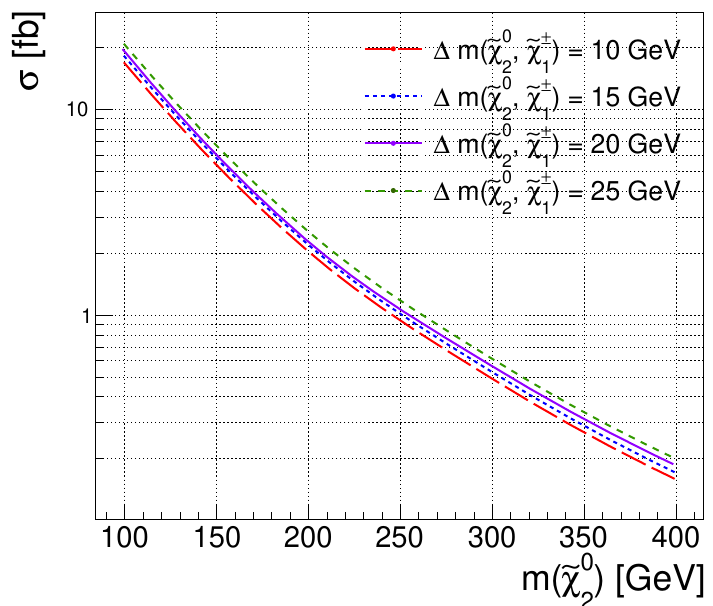
Figure 2 . VBF chargino-neutralino pair-production cross section as a function of m (˜ χ 0